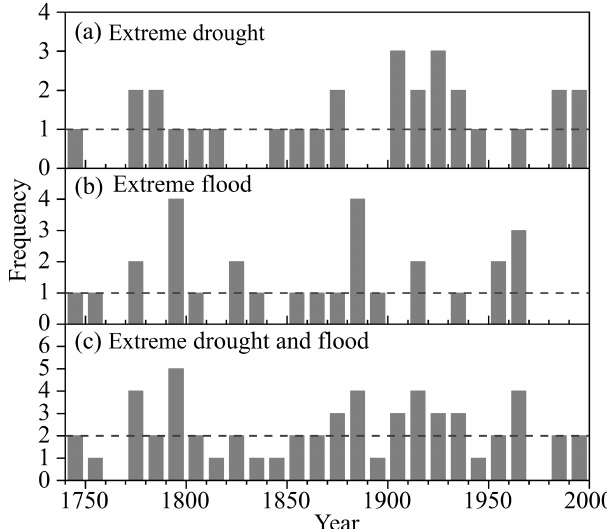
Figure 4. The frequency of extreme drought and flood in North China for each decade from 1740s to